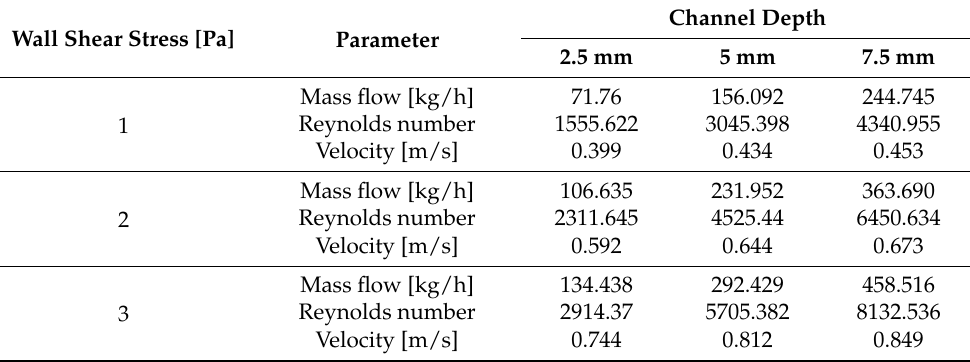
Table A3. Variation of Reynolds number and velocity for constant wall shear stress.